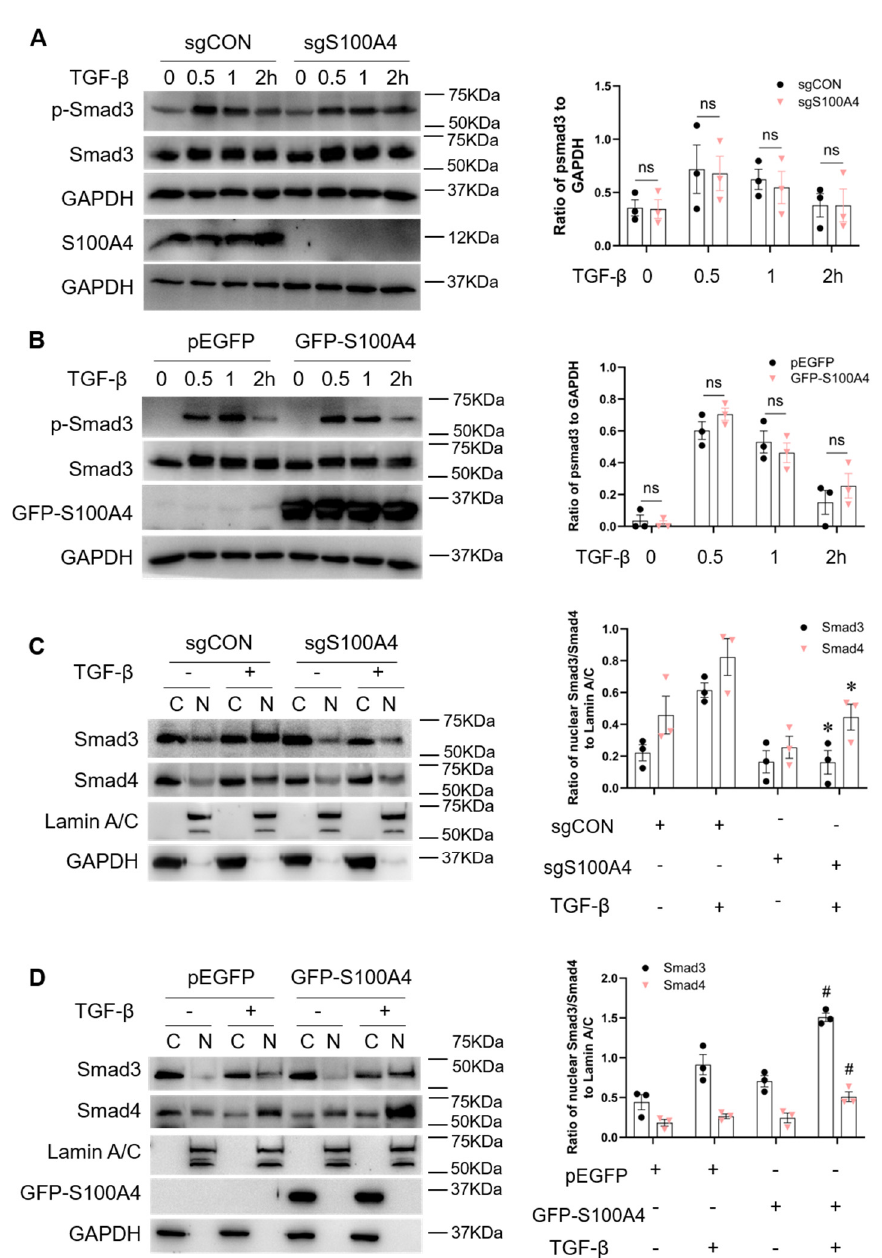
Figure 4. S100A4 promotes Smad3 nuclear translocation with TGF- β 1 treatment. Western blots show phosphorylation of Smad3 in NRK-49F cells with ( A ) S100A4 knockdown and ( B ) Overexpression of S1004A treated with TGF- β 1 (2 ng/mL) at various time points. ( C ) NRK-49F stable cells expressing S100A4 (sgS100A4) were treated with TGF- β 1 (2 ng/mL) for 1 h, and cytoplasmic and nuclear fractions were prepared. Protein levels of Smad3 and Smad4 were determined by immunoblotting analysis. ( D ) NRK-49F cells transduced with pEGFP or GFP-S100A4 were treated with TGF- β 1 (2 ng/mL) for 1 h, and cytoplasmic and nuclear fractions were prepared. Cell extracts were analyzed for protein levels of Smad3 and Smad4 by Western blot analysis. Data are expressed as Mean ± SEM of three independent experiments. * p < 0.05 vs. sgCON + TGF- β 1 and # p < 0.05 vs. pEGFP + TGF- β 1.